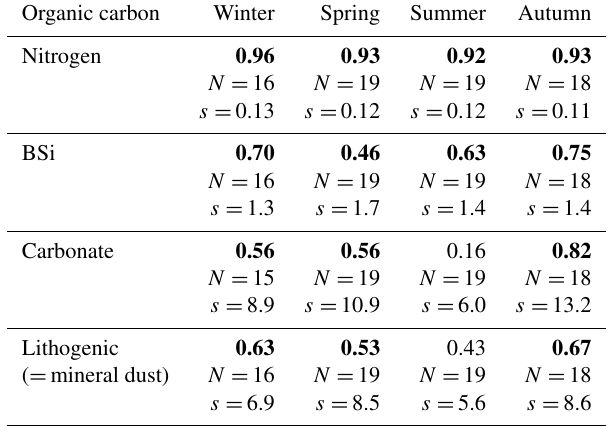
Table 3. Correlation coefficients between organic carbon flux and major bulk flux components for the four different seasons (lower trap data only). Number of data points ( N ) and the slopes ( s ) for the regression lines are given as well. Statistically significant values for R 2 at a 99.9% confidence level are indicated in